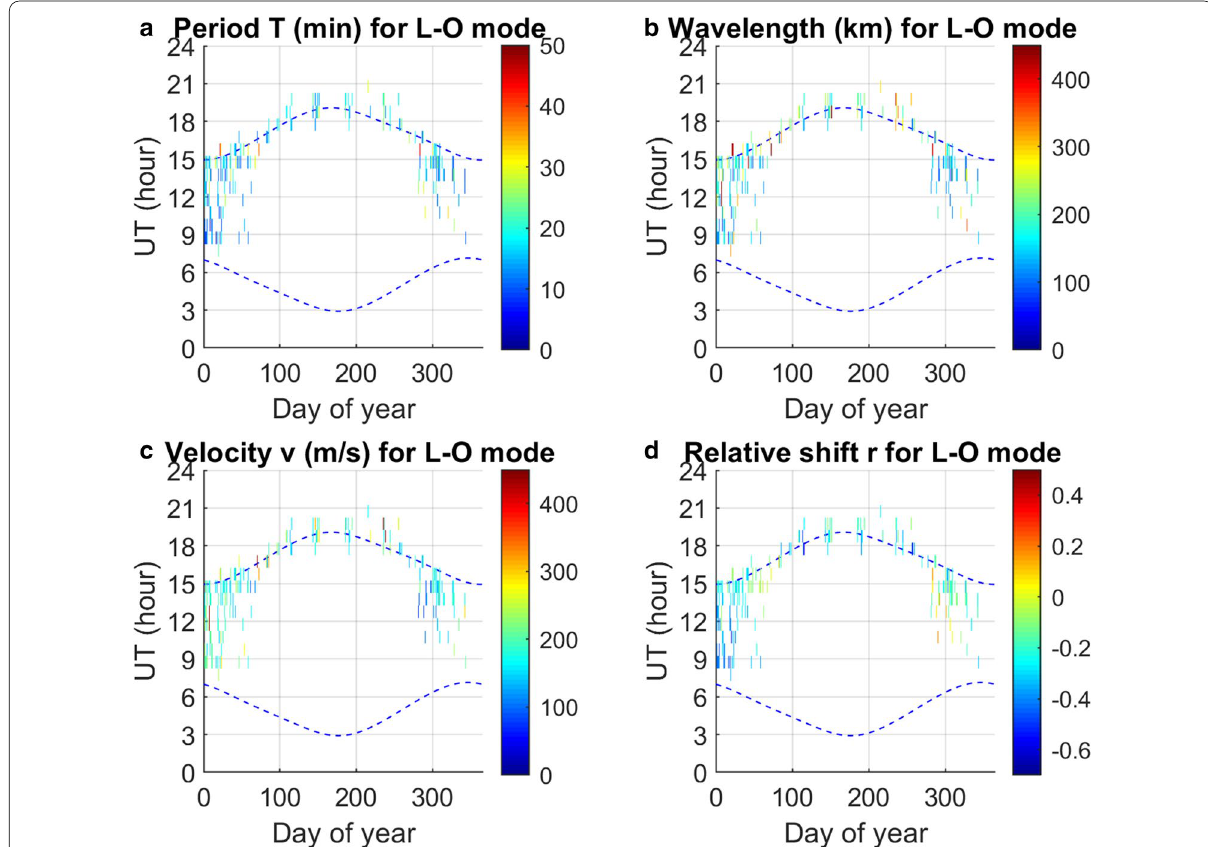
Fig. 6 Period T , wavelength λ , velocity v and relative Doppler shift r for the period July 2014–June 2015 (solar maximum) and L-O mode. The values are color-coded. Dashed lines indicate times of sunrise and